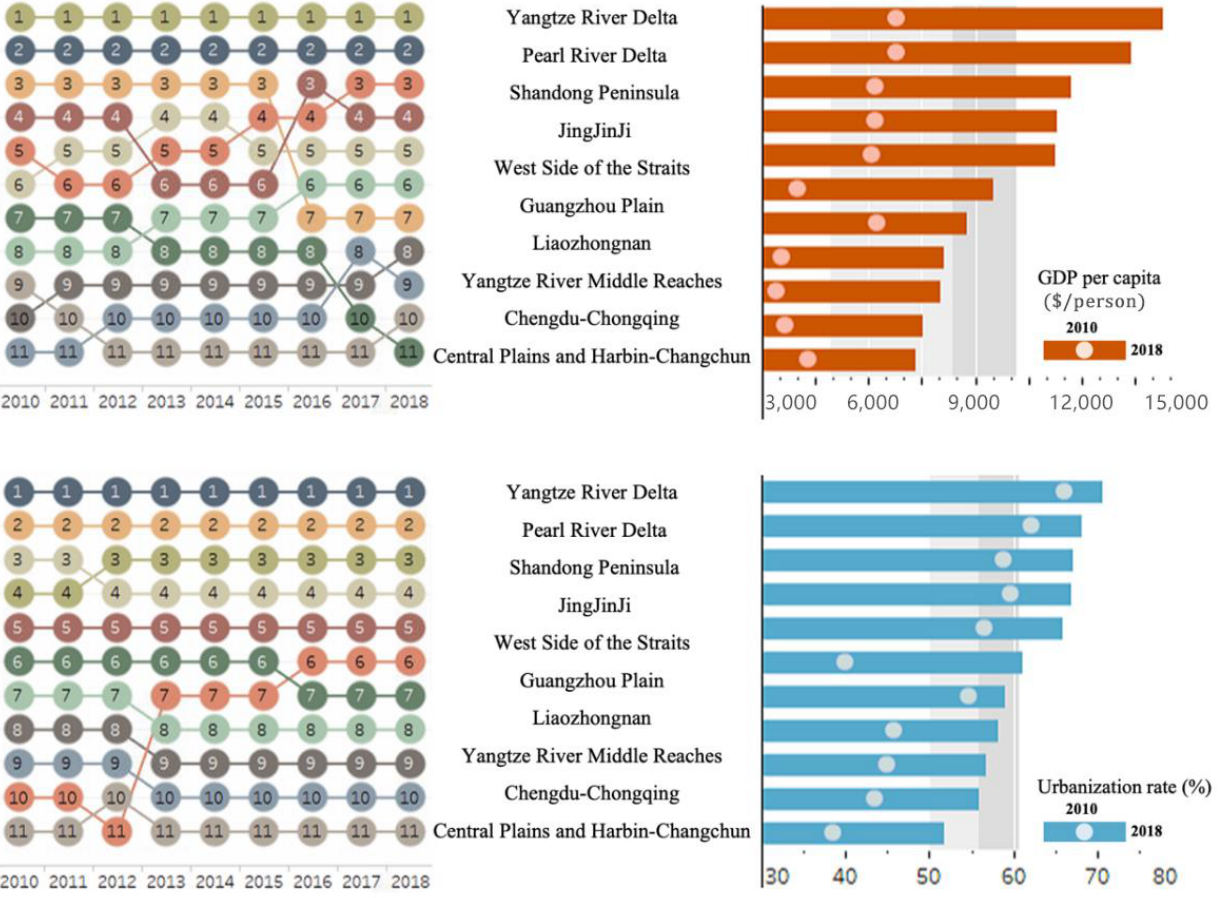
Figure 2. Comparative analysis of GDP and Urbanization rate among 11 megalopolises in China from 2010 to 2018. (Data source: China Statistical Yearbook 2011–2019 [36]).